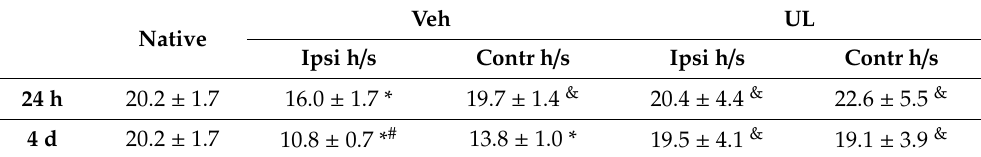
Coenzyme Q10 brain level 24 h and 4 days after middle cerebral artery